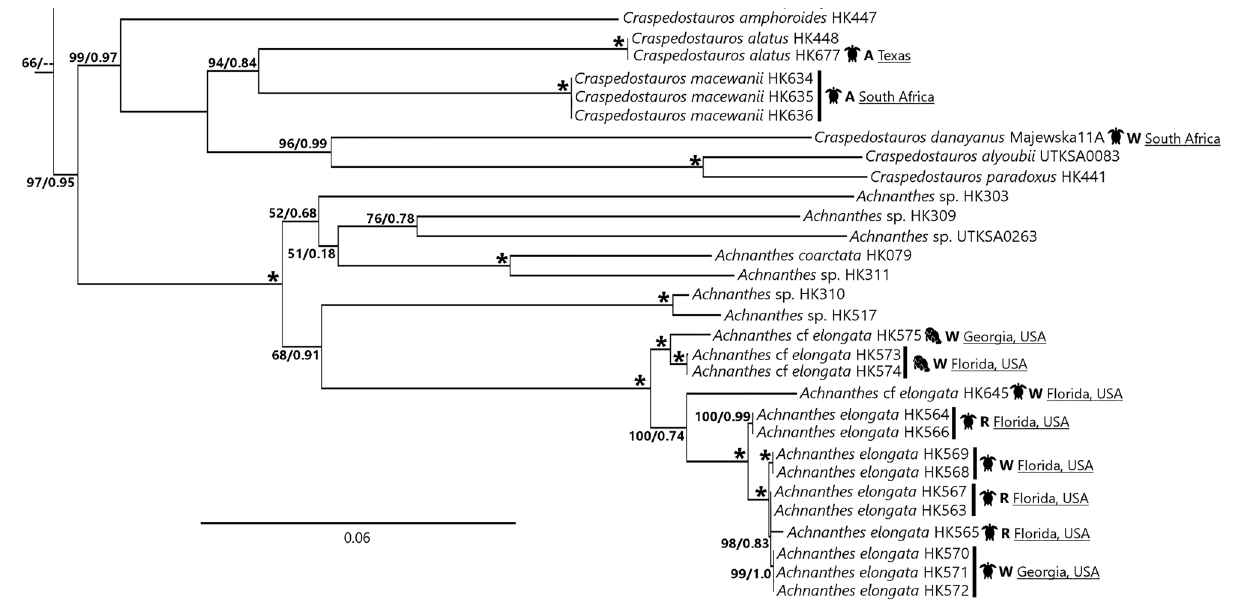
Figure 1. Maximum likelihood phylogenetic tree derived from a concatenated 3-gene DNA sequence dataset, representing the Achnanthes , Craspedostauros and Staurotropis clades (complete tree shown in Fig. S1). Support values (ML bootstrap support/BI posterior probability) shown above nodes; “*” = nodes with 100%/1.0 values. Taxon name followed by DNA extraction voucher number or strain ID. Taxa isolated from epizoic habitats followed by a diagrammatic representation of the host from which the strain was isolated, and metadata on the location and setting in which the host was sampled (A = aquarium, R = rehabilitation facility, W = wild).